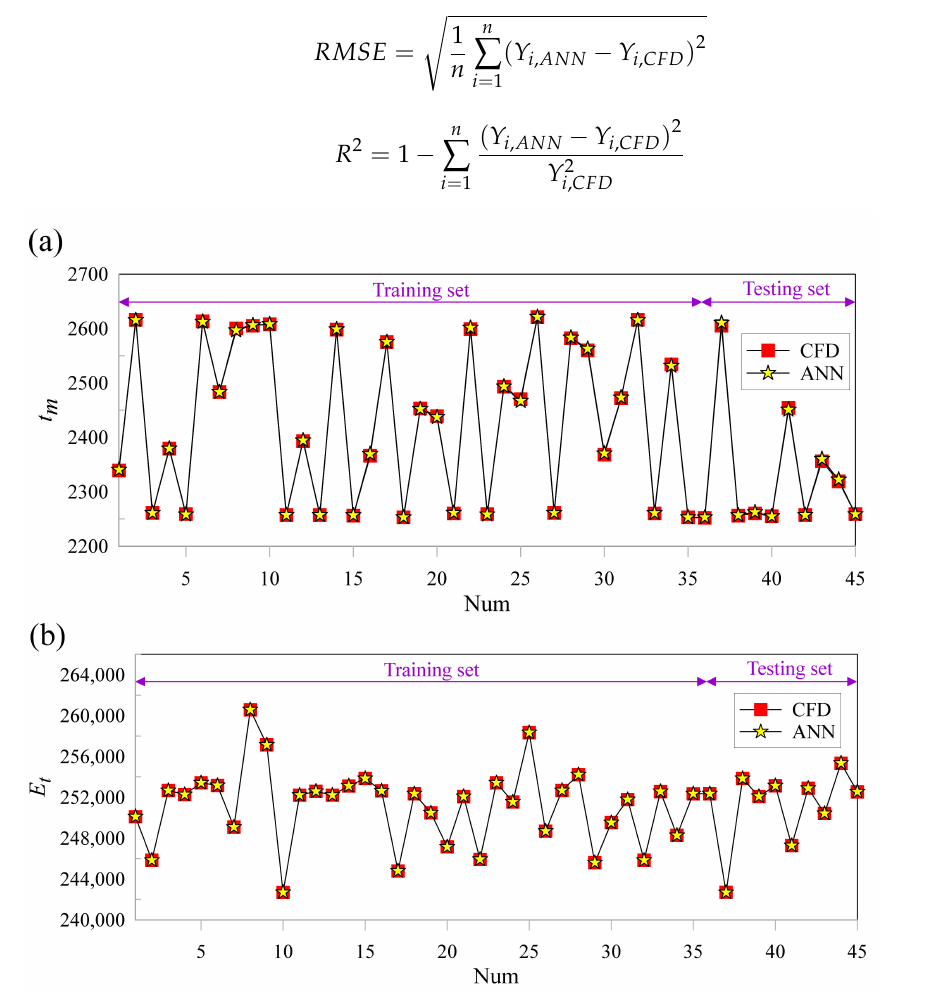
Figure 7. Comparison of CFD and predicted ANN values for ( a ) t m and ( b ) E t